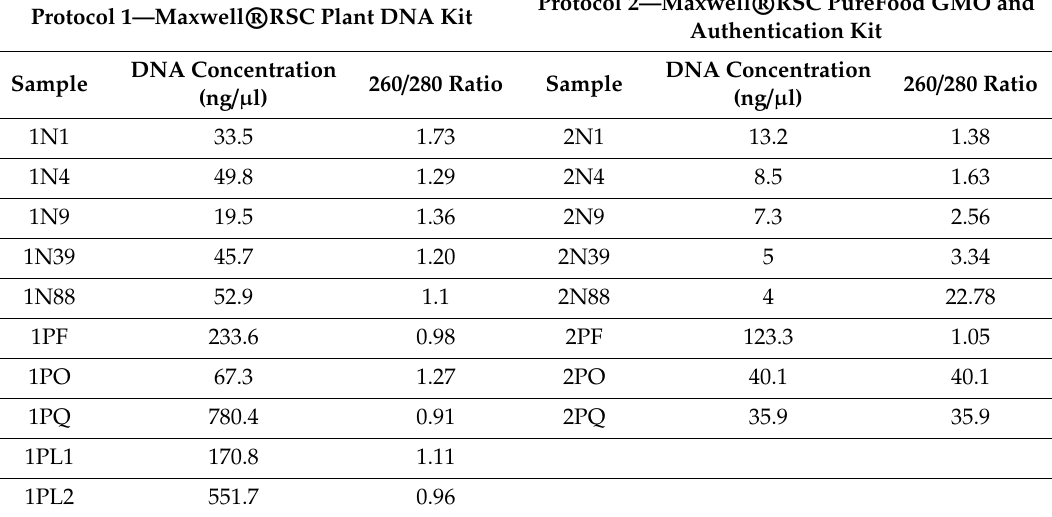
Table 3. Values of DNA concentration and purity obtained for the two extraction protocols.